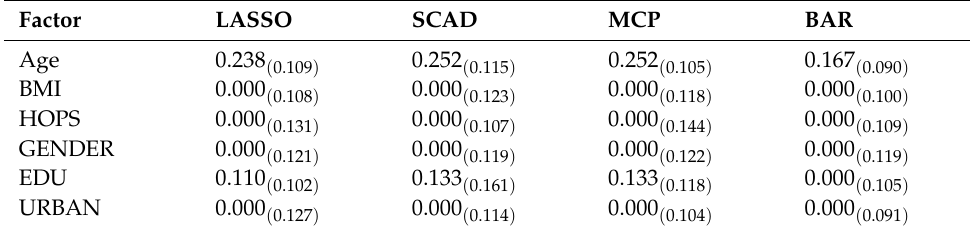
Table 8. Analysis results of children’s mortality data based on choice (II).